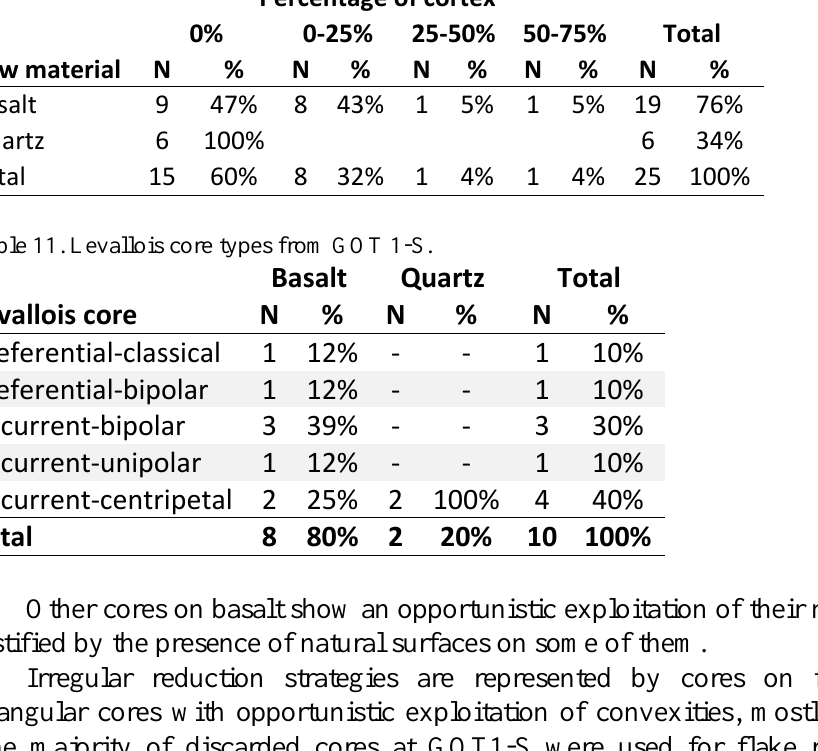
Table 10. Percentage of cortex among cores from GOT 1-S. Percentage of cortex